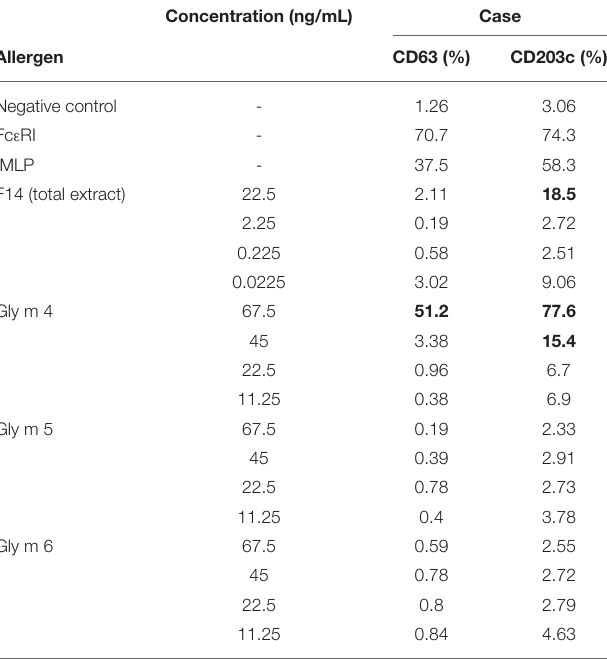
CD63 and CD203c results are expressed as a percentage of the maximum basophil activation obtained (or CD max). The threshold of positivity corresponds to a minimum of 15% of activation. Positive values appear in